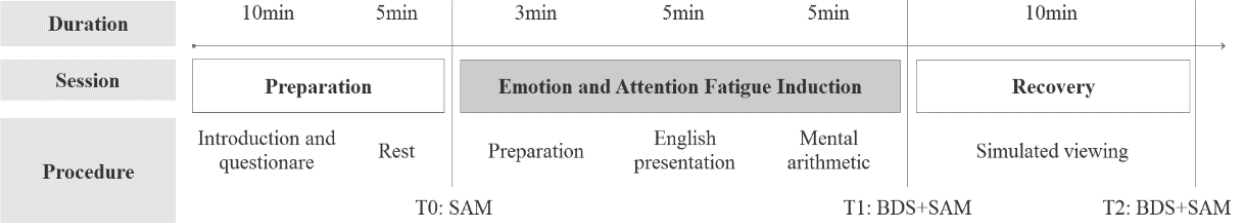
Figure 2. Experimental procedure.